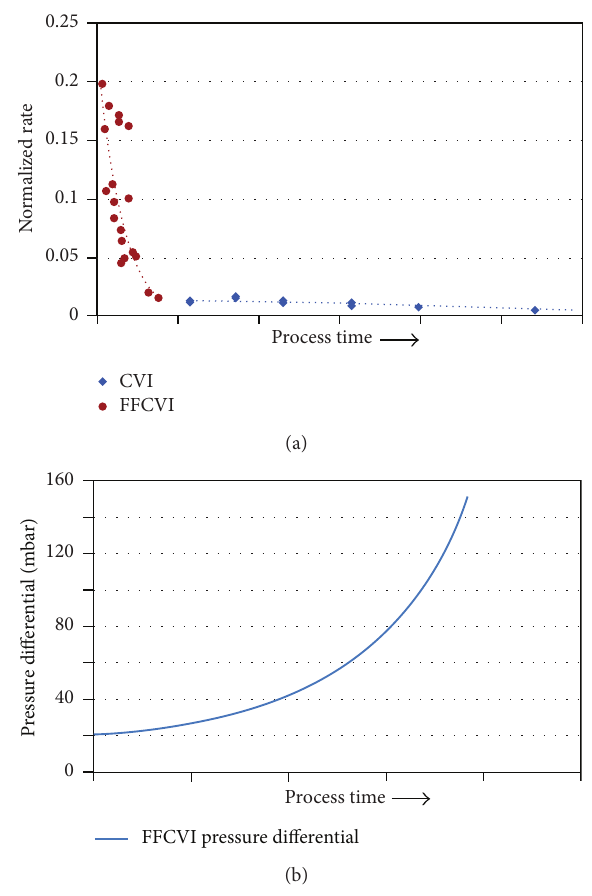
Figure 2: (a) Plot of normalized rate of mass gain as a function of process time for conventional CVI and FFCVI and (b) plot of increasing pressure differential across sample observed during